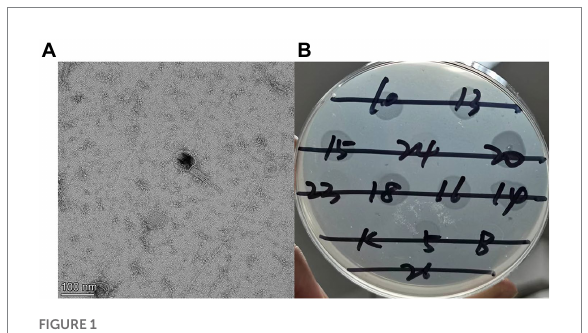
FIGURE 1 Transmission electron microscopy (A) and host range (B) of phage PaVOA.